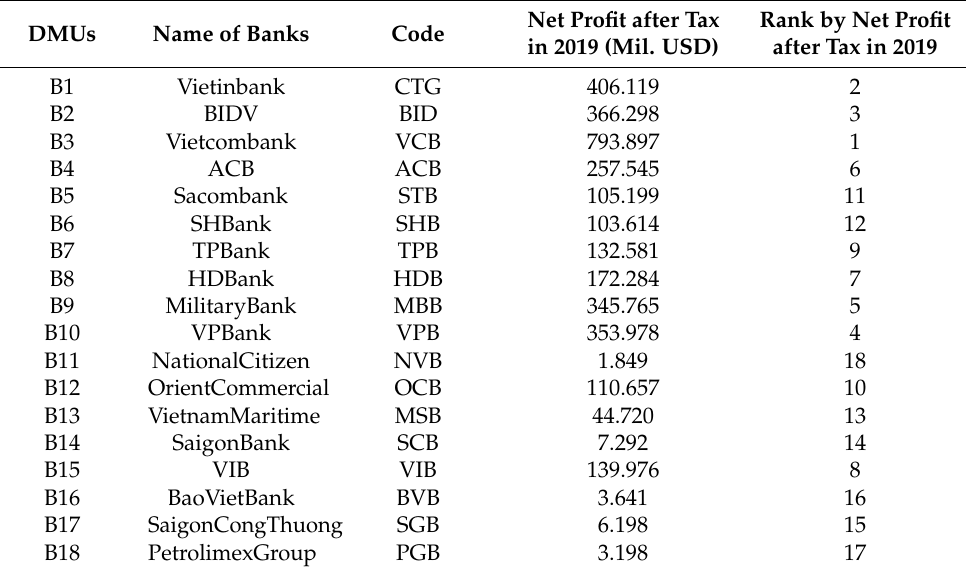
Table 2. List of the top commercial banks in